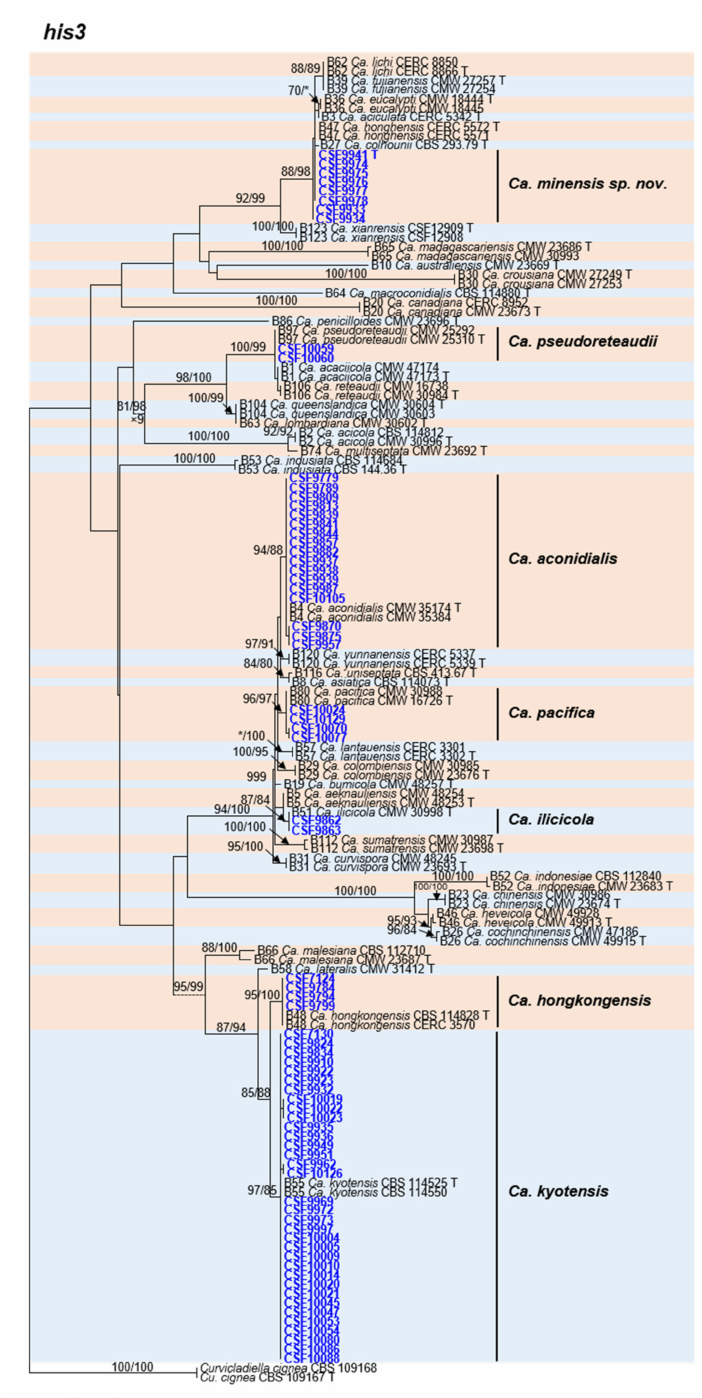
Figure A3. Phylogenetic tree of Calonectria species based on maximum likelihood (ML) analyses of his3 gene sequences. Bootstrap value ≥ 70% for ML and MP analyses are presented at the branches. Bootstrap values lower than 70% are marked with “*”, and absent analyses values are marked with “-”. Ex-type isolates are marked with “T”. Isolates sequenced in this study are highlighted in blue and bold type. The “B” species codes are consistent with the recently published results in Liu and co-authors [18]. The tree was rooted to Curvicladiella cignea (CBS 109167 and CBS